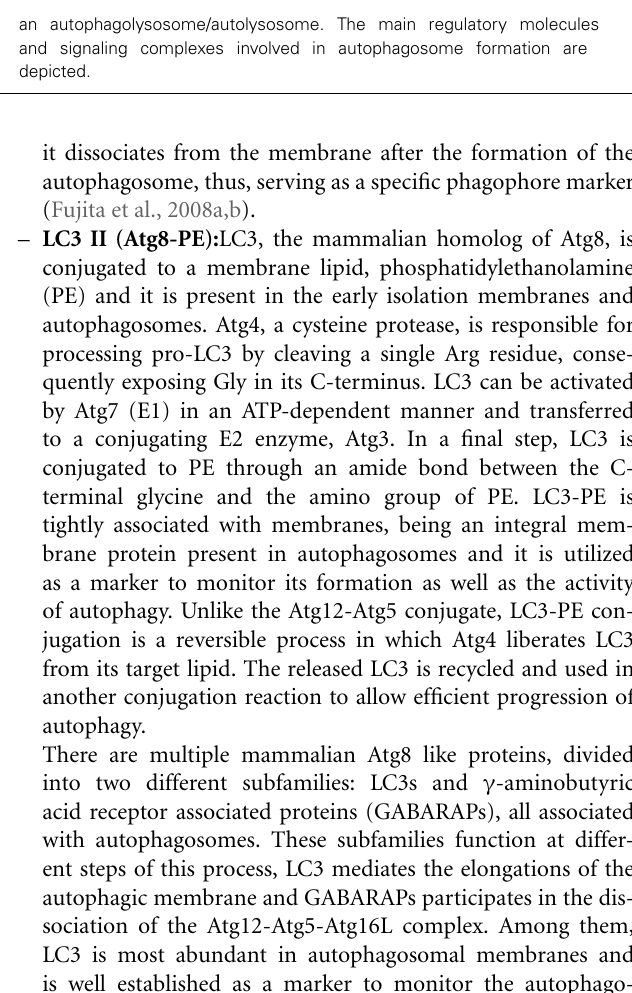
an autophagolysosome/autolysosome. The main regulatory molecules and signaling complexes involved in autophagosome formation are